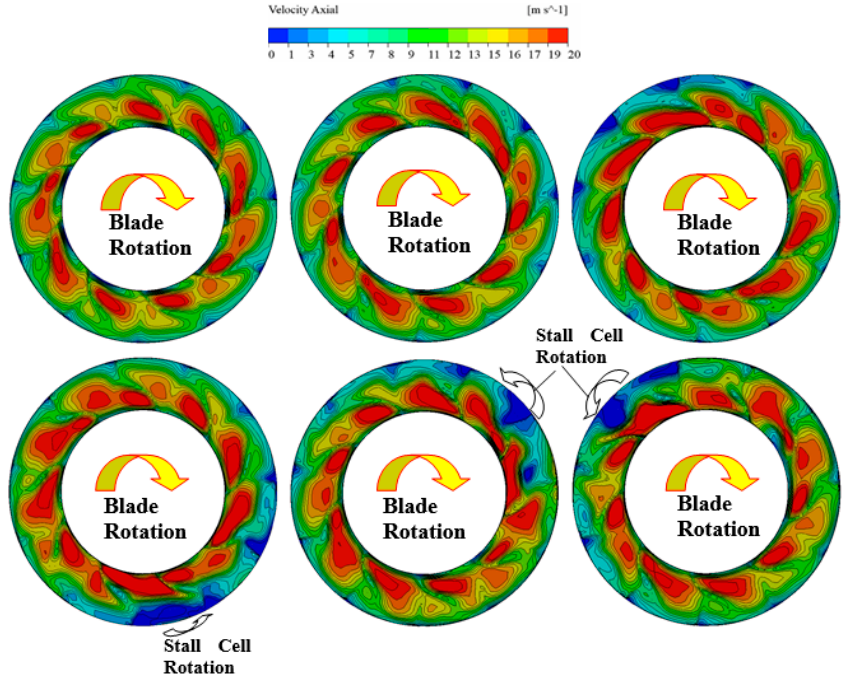
Figure 19. Transient flow characteristics of the rotor outlet surface.